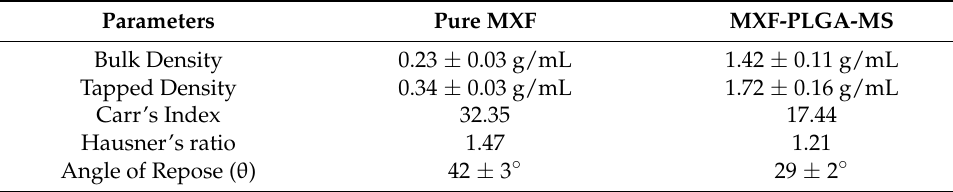
Table 2. Micromeritics properties of the free MXF and optimized MXF-PLGA-MS. Parameters